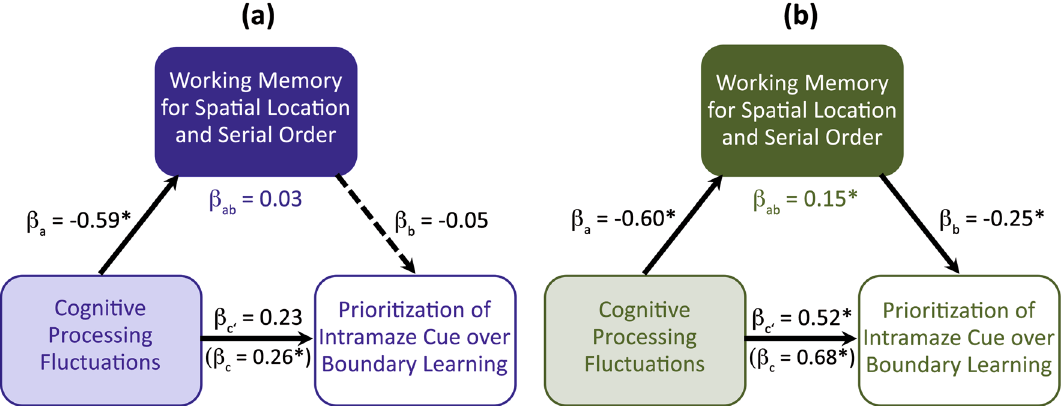
Figure 4. Schematic diagram of the mediational analyses for the child developmental subsample (panel a ) and the adult developmental subsample (panel b ). The model tested whether the effect of individual differences in cognitive processing fluctuations (independent variable) in predicting individual differences in the relative prioritization of intramaze cue-based over boundary-based learning is mediated by spatial working memory (mediation variable). Path coefficients are unstandardized beta (β) scores. The β c ′ scores reflect the direct effect of the independent on the dependent variable when controlling for the mediator variable. The β c scores in parenthesis reflect the total effect (i.e., the sum of the direct and the indirect effect). The partial mediation (β ab ) only reached significance in the adult development sample (penal b). * p <